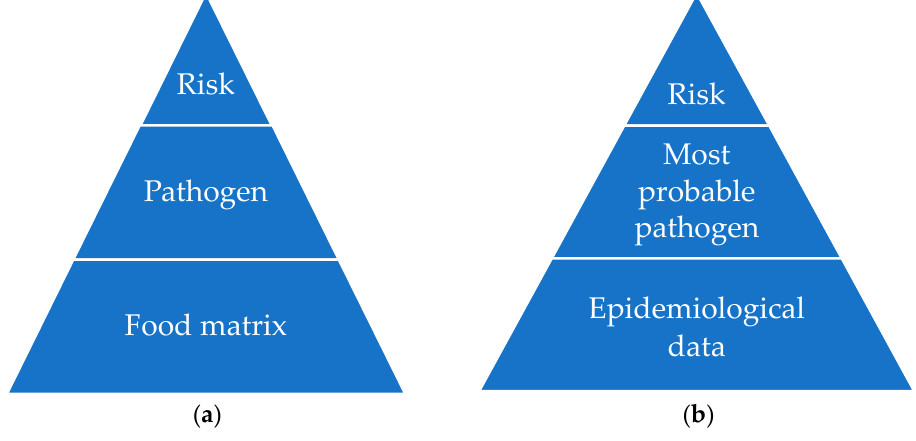
Figure 1. Graphical representation of the top-down ( a ), and bo tt om-up ( b ) approaches.